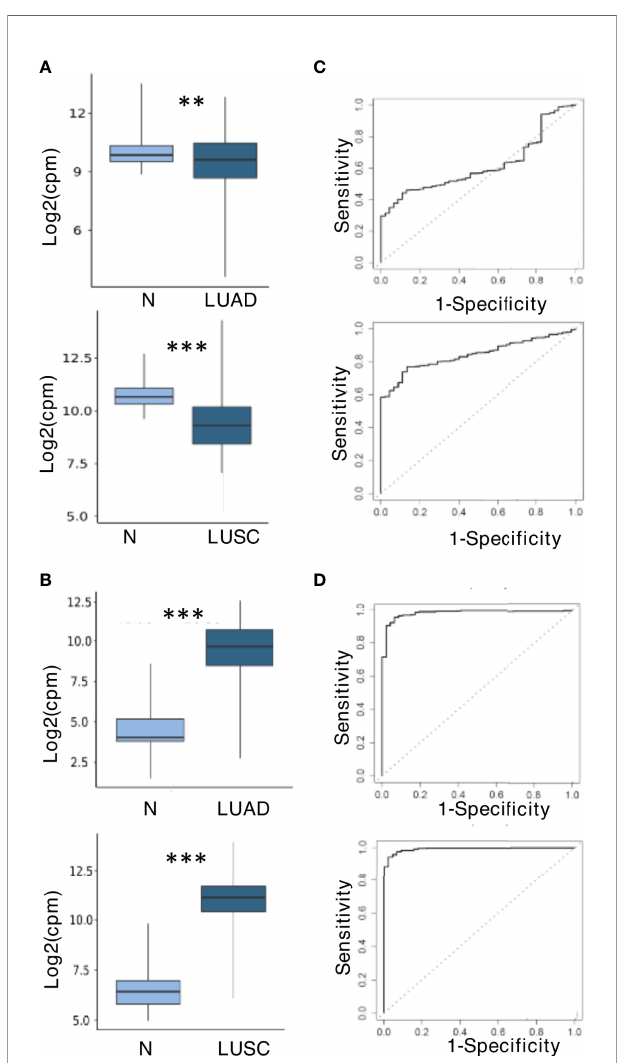
FIGURE 6 | miR-150-5p and miR-210-3p expression and predictive value at tissue level in The Cancer Genome Atlas (TCGA) dataset. (A) Downregulation of miR-150-5p. (B) Upregulation of miR-210-3p. The upper and lower boxplots in (A, B) refer, respectively, to lung adenocarcinoma (LUAD) and lung squamous cell carcinoma (LUSC) compared with normal lung samples in the TCGA cohort. The log 2 (fold change) values for the magnitude of difference are as follows: -0.56 (LUAD vs. normal) and -1.45 (LUSC vs. normal) for miR-150-5p; 5.02 (LUSC vs. normal) and 4.46 (LUSC vs. normal) for miR-210-3p. The P -value by unpaired two-tailed Student ’ s t -test are as follows: ** P ≤ 0.01; *** P ≤ 0.001. (C) Receiver operating characteristic (ROC) curves for miR-150-5p. (D) ROC curves for miR-210-3p. LUADs are displayed in the upper boxplots, and LUSC are in the lower boxplots of (C,D)